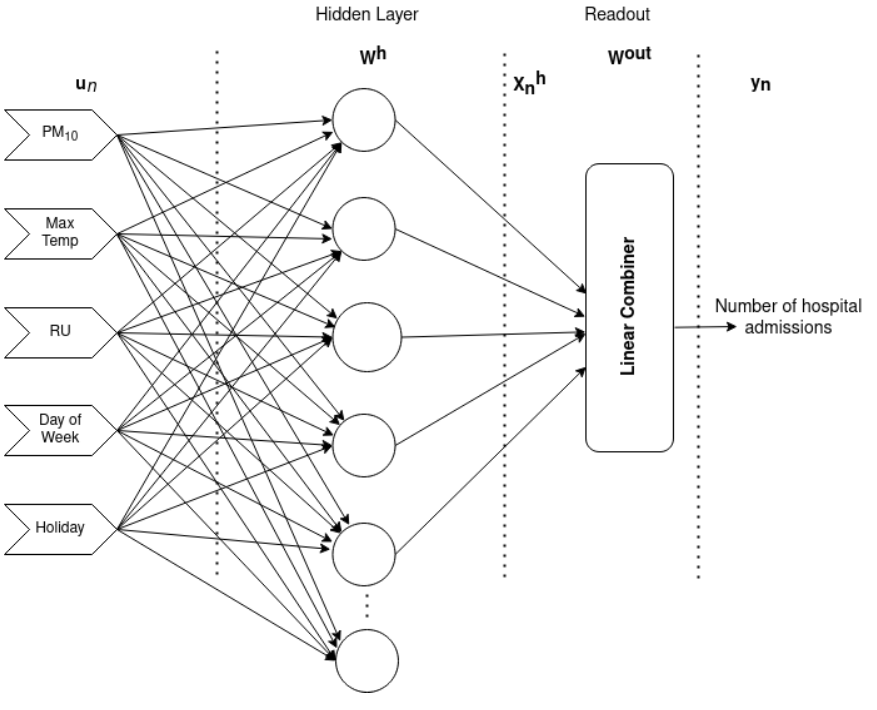
Figure 1. Extreme Learning